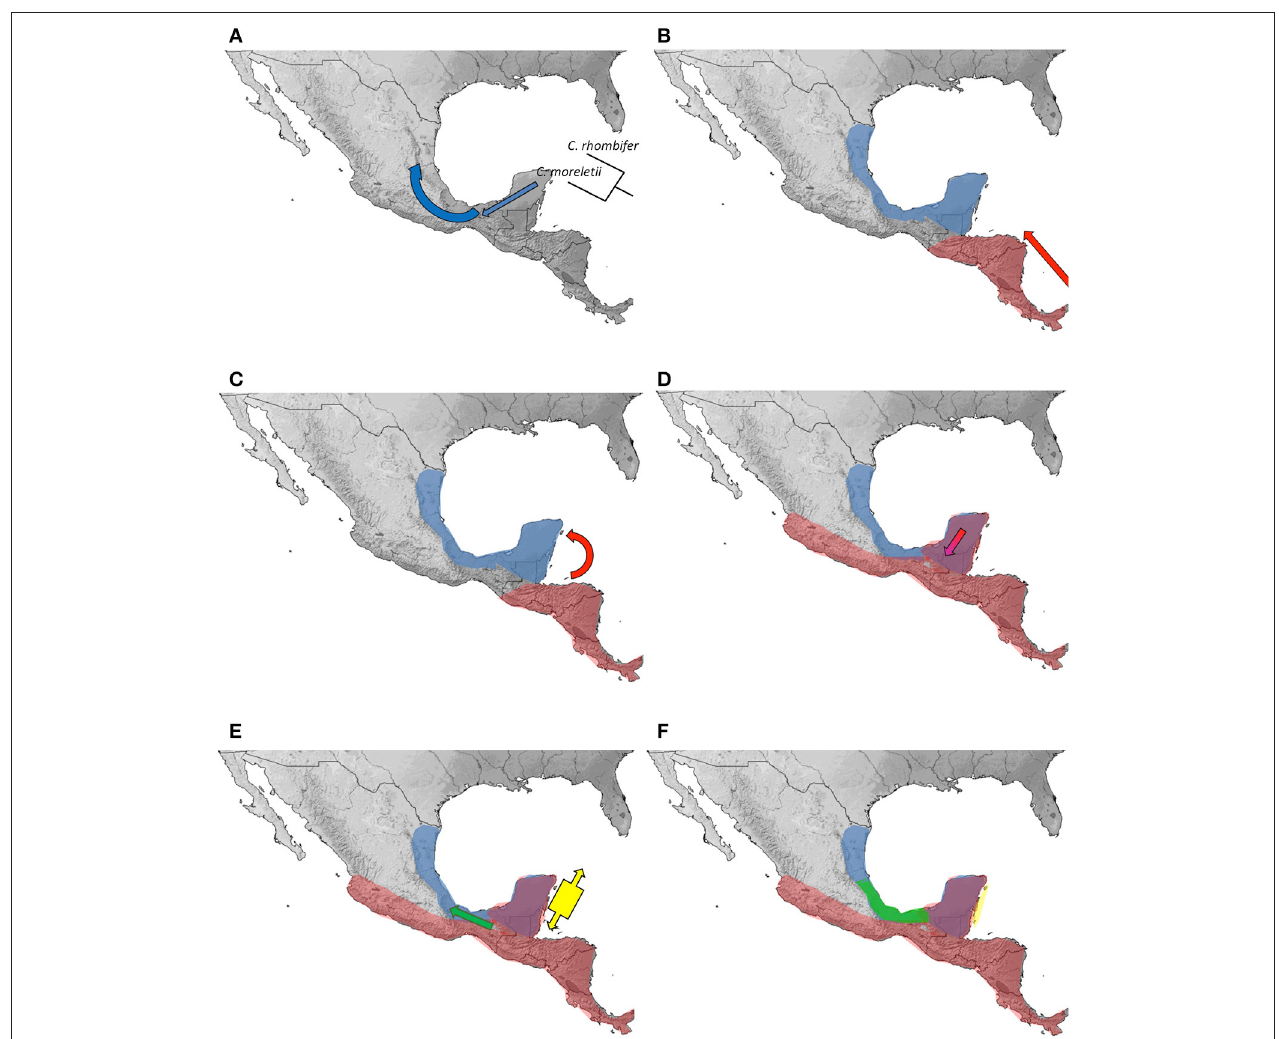
FIGURE 7 | Biogeographical hypothesis about the secondary contact and hybridization process between Crocodylus acutus and C. moreletii , based on their geographic distribution, estimated divergence times, and genomic-based clustering results: (A) split between Crocodylus moreletii (Mexico) and its sister species C. rhombifer (Cuba), occuring around 6.2 million years ago (My) and dispersal to the Yucatan peninsula, (B) ancestral Crocodylus acutus dispersed through Central America, reaching the Mexican region ca. 4.7–3.5 My, (C) C. acutus arrival to the Yucatan peninsula about 3 My, when the oldest hybridization events could have initiated, (D) the first secondary contact zone on the northern Yucatan peninsula was formed nearly 2.5 My; C. acutus dispersed through the Isthmus of Tehuantepec reaching the Pacific and followed along the coast, (E) about 3–2.5 My ago C. acutus also dispersed into the Mexican Caribbean region and likely to other Central American islands and cays, (F) the hybridization process continued toward both the north and the south, reaching the northernmost distribution along the Gulf of Mexico, and forming the cline we observe in the